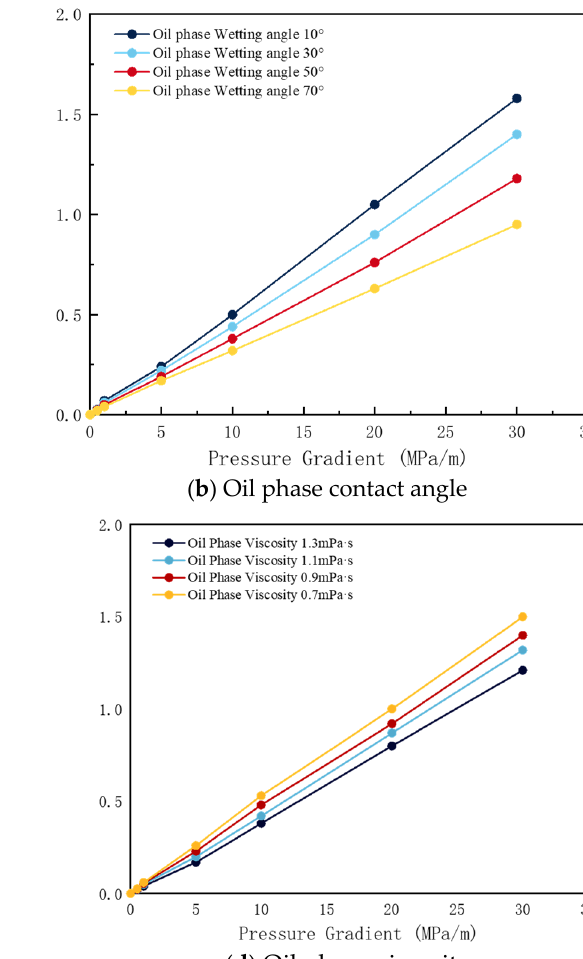
Figure 23. Simulation results of oil in bedding fractures under different pressure gradient condi- tions. Figure 24 shows the relationship between the single-phase flow velocity of crude oil